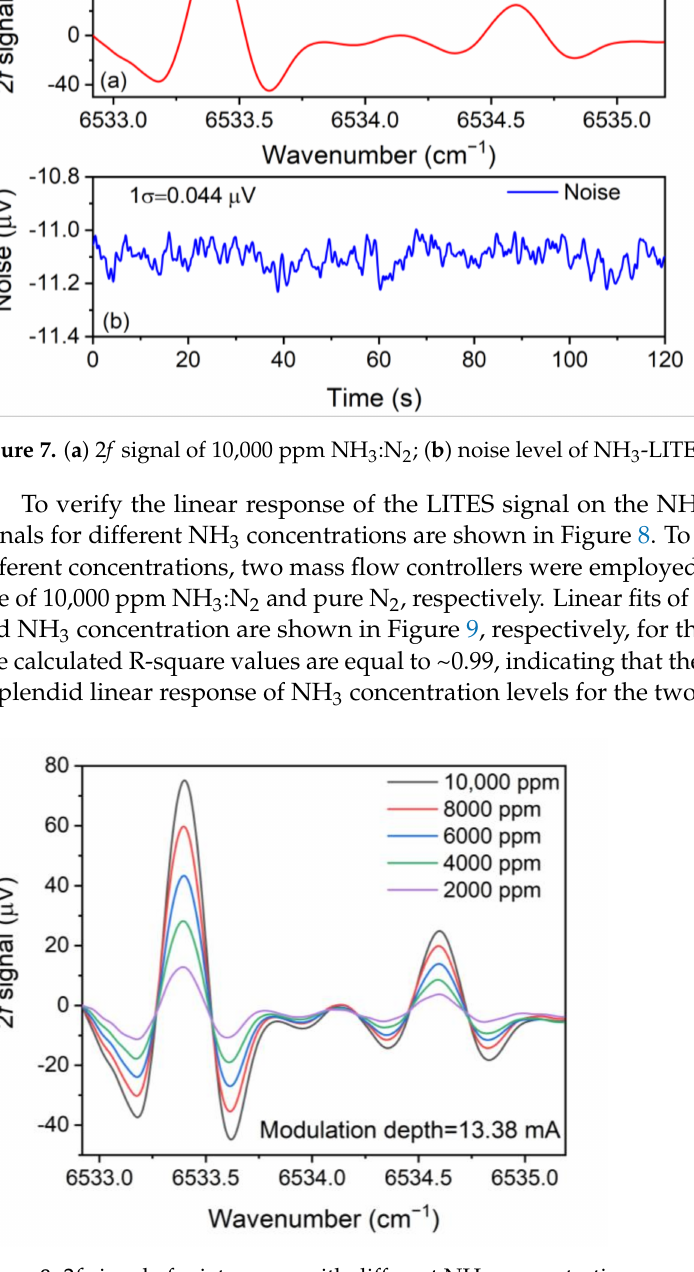
Figure 8. 2 f signal of mixture gas with different NH 3